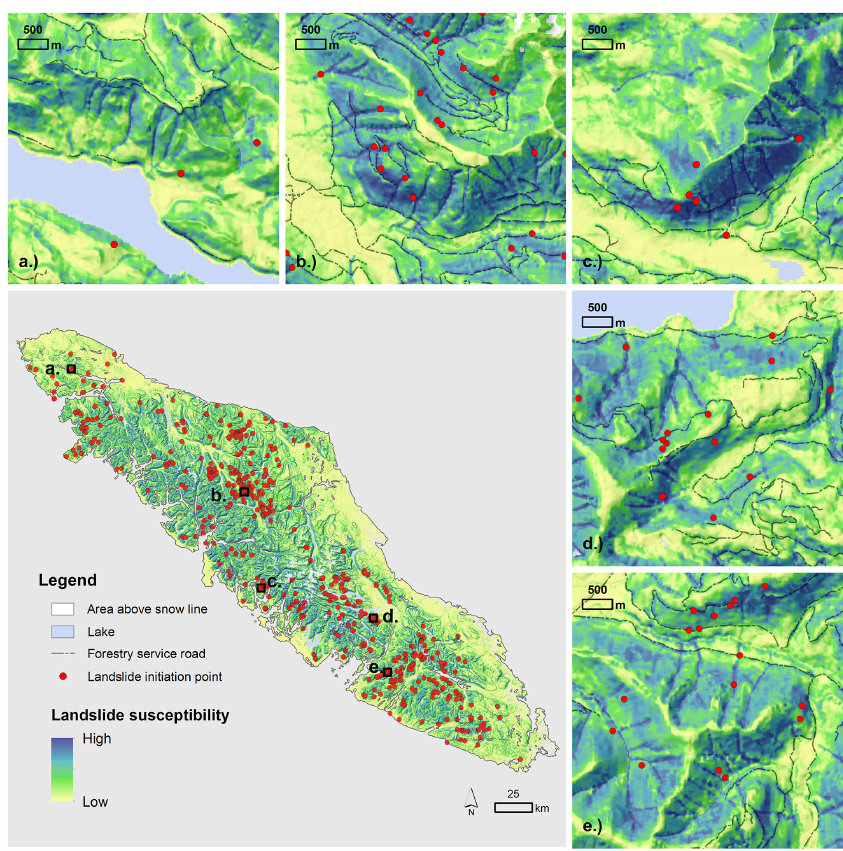
Figure 10. Model-derived landslide susceptibility map for Vancouver Island: overview and (a–e) selected example